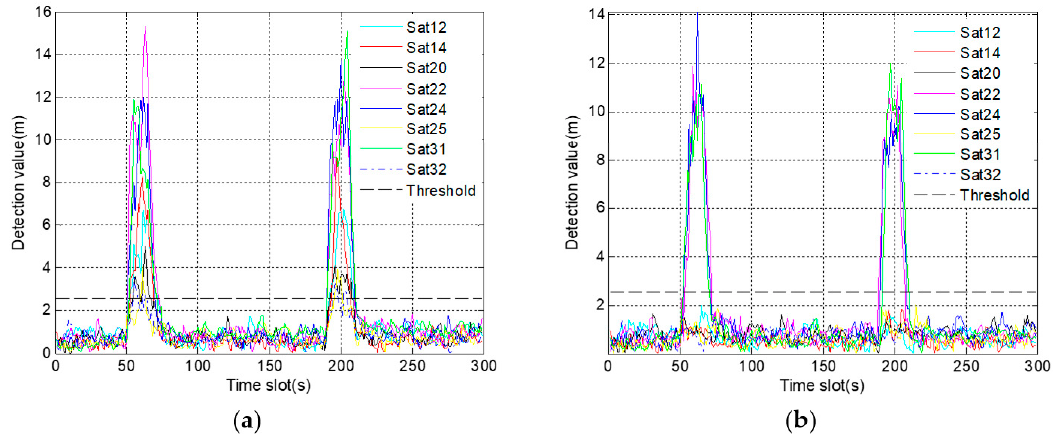
Figure 16. The graph of fault identification statistics during occlusion: ( a ) before using a robust algorithm; ( b ) after using a robust algorithm.